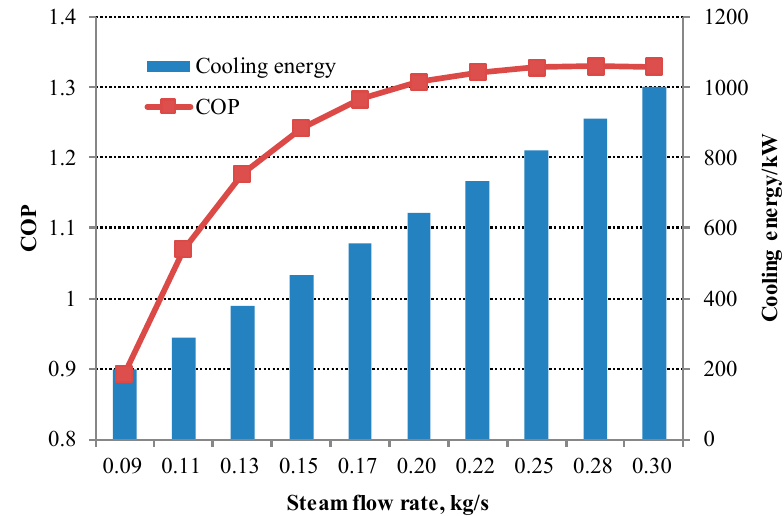
Figure 7. Variations in the cooling load and COP with respect to the steam flow rate.